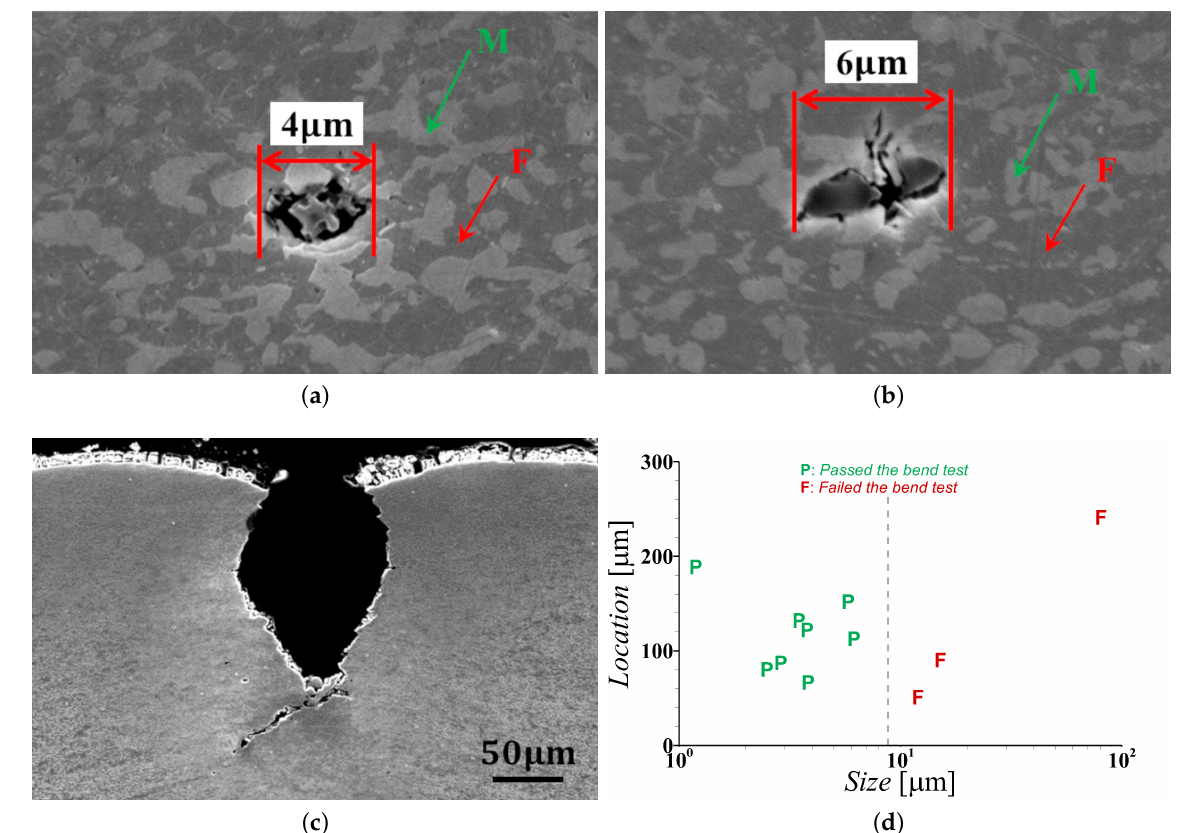
Figure 1. SEM images of an advanced high strength dual-phase, DP1000, steel specimens showing ( a , b ) the ‘intended’ ferritic (F)-martensitic (M) microstructure and ‘unintended’ subsurface inclusions in the undeformed material and ( c ) cross-section of a deep surface crack formed during 90 ◦ V-bending. ( d ) Experimental results showing the effects of the location (distance from the tension side free surface) and size of subsurface inclusions on the bendability of DP1000 steel